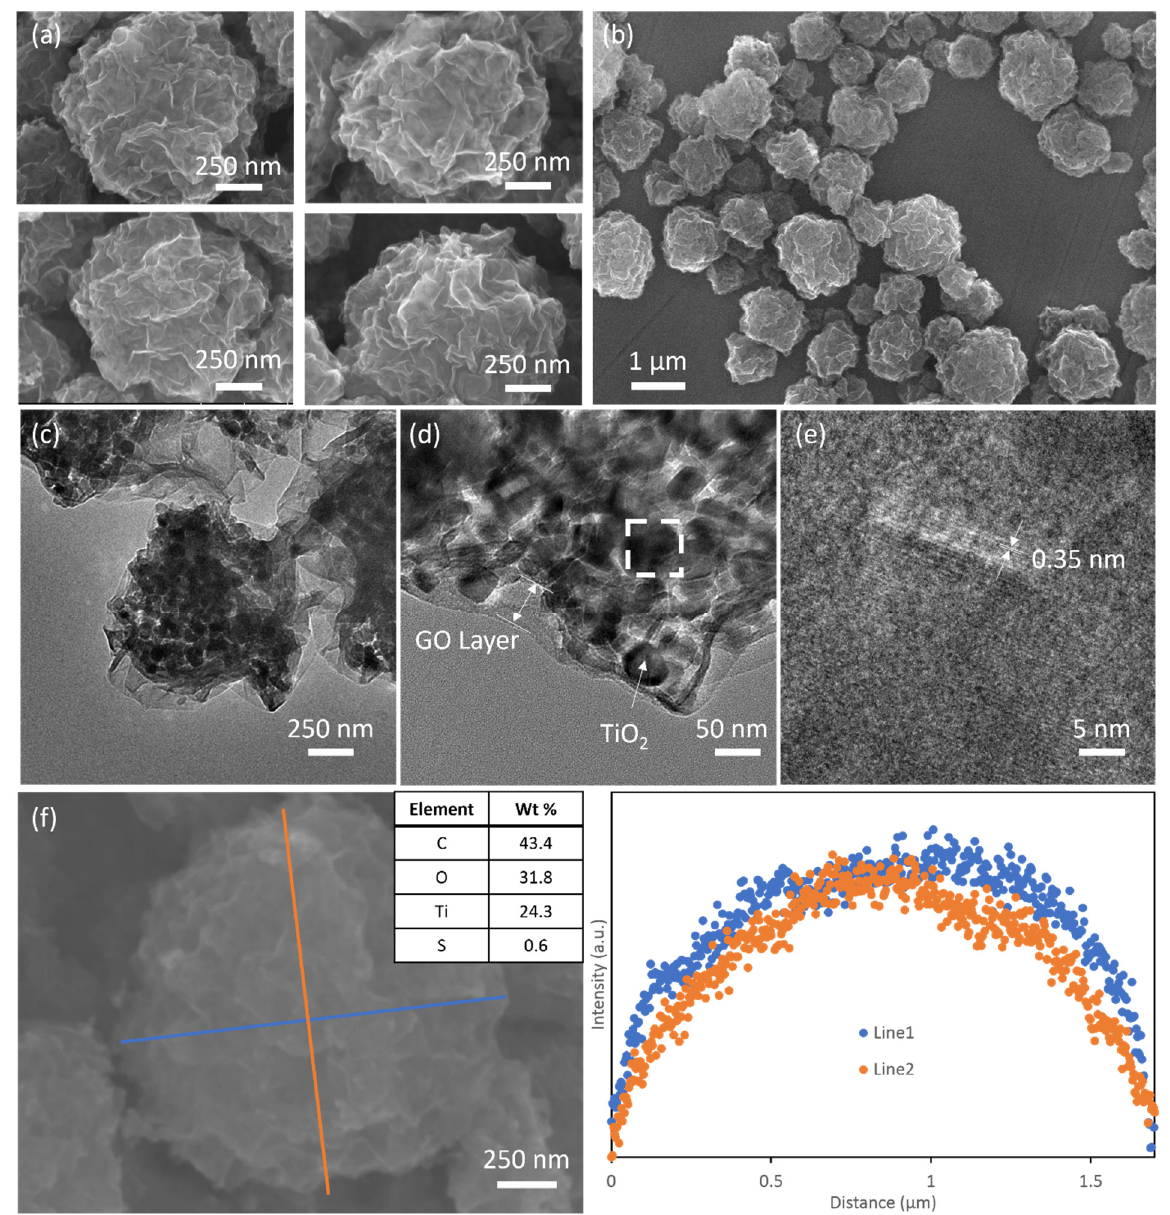
Figure 1. ( a , b ) SEM images of TiGC; ( c , d ) TEM images of TiGC; ( e ) HRTEM images of TiGC (enlarged area outlined in ( d )); ( f ) EDS overall element analysis and two line scans of titanium in TiGC.